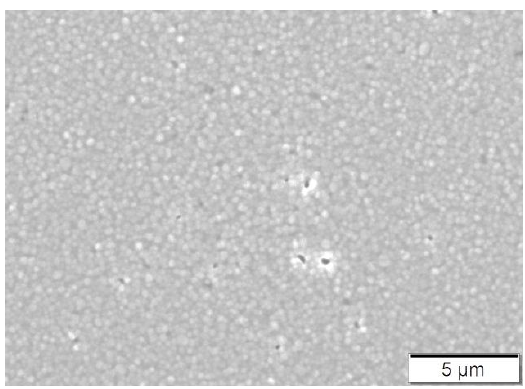
Figure 7. Typical microstructure of a sintered specimen.